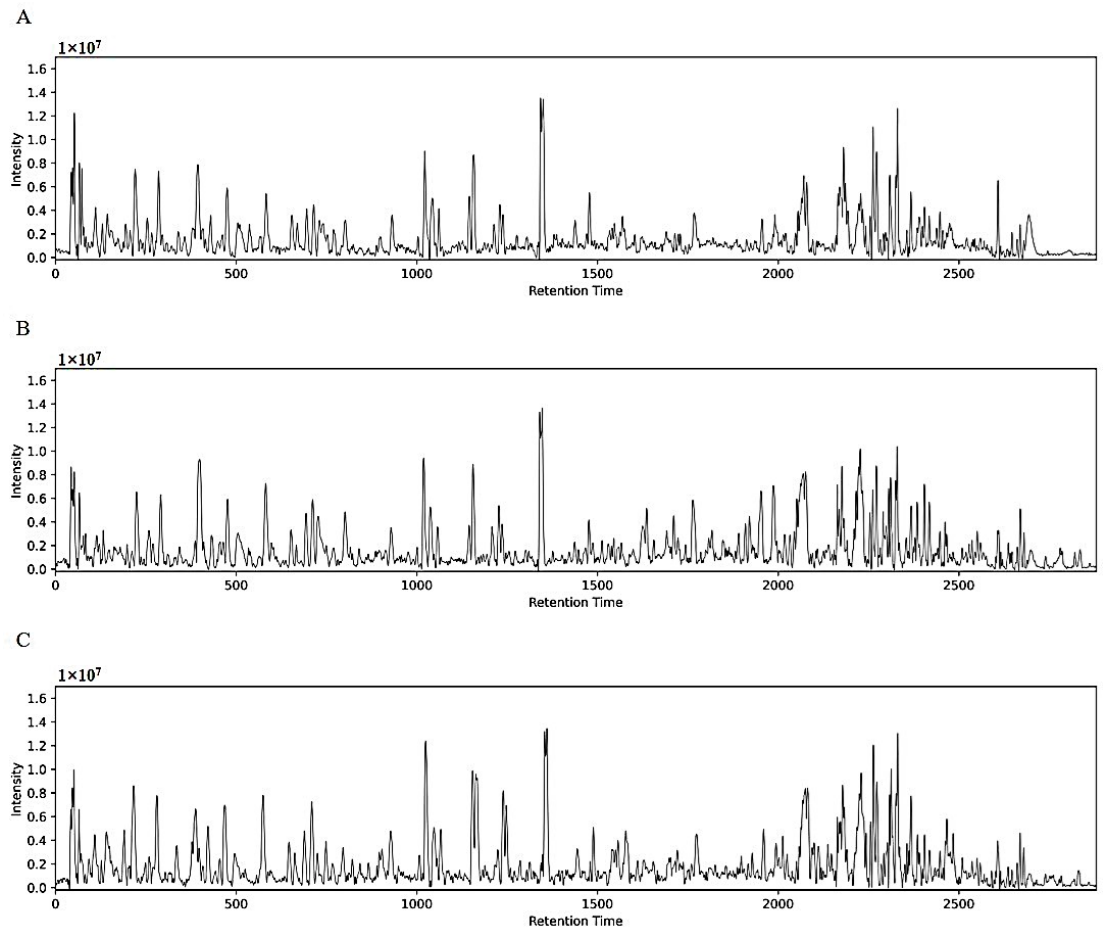
Figure 5. The base peak chromatogram of the flue-cured NTL leaves from different maturity grades. ( A ) The base peak chromatograms (BPC) plot of unripe leaves at m/z range of 50–1000; ( B ) the BPC plot of ripe leaves at m/z range of 50–1000; ( C ) the BPC plot of overripe leaves at m/z range of 50–1000.